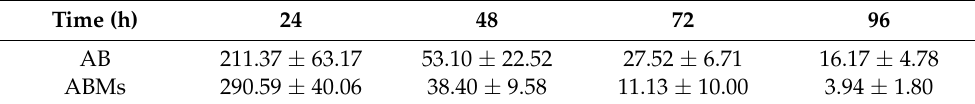
Table 3. IC 50 values ( µ M) of AB and ABMs (Values represent mean ± SD, n = 3). Time (h) 24 48